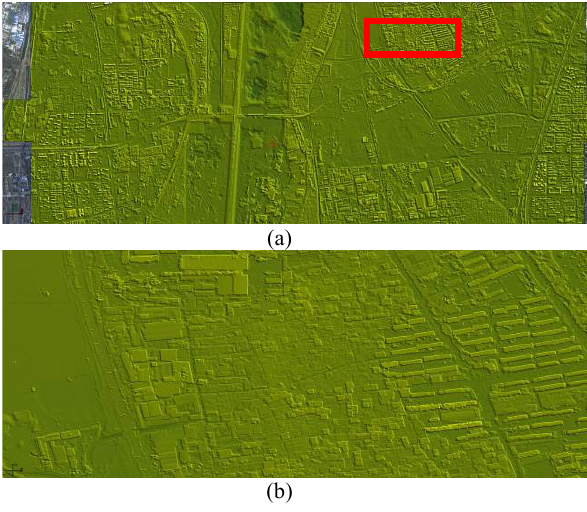
Figure 4. DSM result of 2017. (a) the whole range of DSM result of 2017, (b) local DSM of red rectangle range of (a) The edges of building in built-up area easier to detect in Figure 4(b). Using the raster calculator, subtraction operation of the DSM data is performed to get the difference of DSM data. According to the requirements, the corresponding display intervals are designated and rendered according to different colors and the final results are as follows. Figure 4 shows the TDOM (Figure 5 (a) and Figure 5(b)) and final change detection result(Figure 5 (c) –Figure 5 (f)).